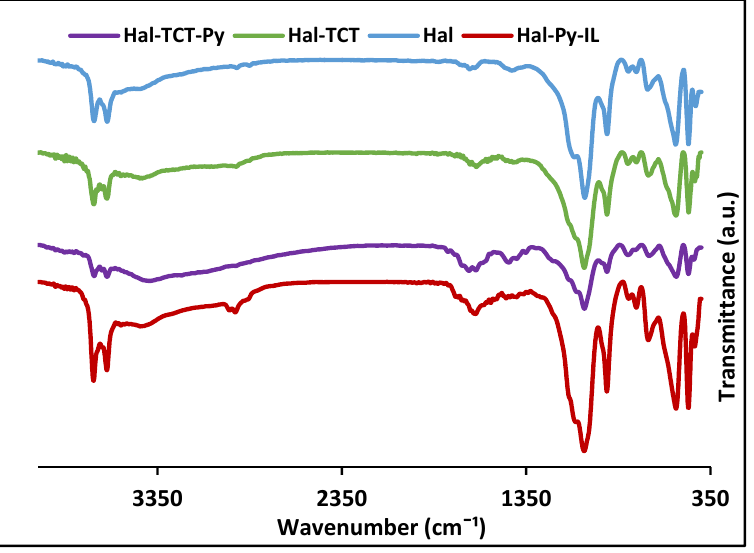
Figure 6 . FTIR spectra of Hal, Hal-TCT, Hal-TCT-Py, Hal-Py-IL. Figure 6. FTIR spectra of Hal, Hal-TCT, Hal-TCT-Py, Hal-Py-IL.